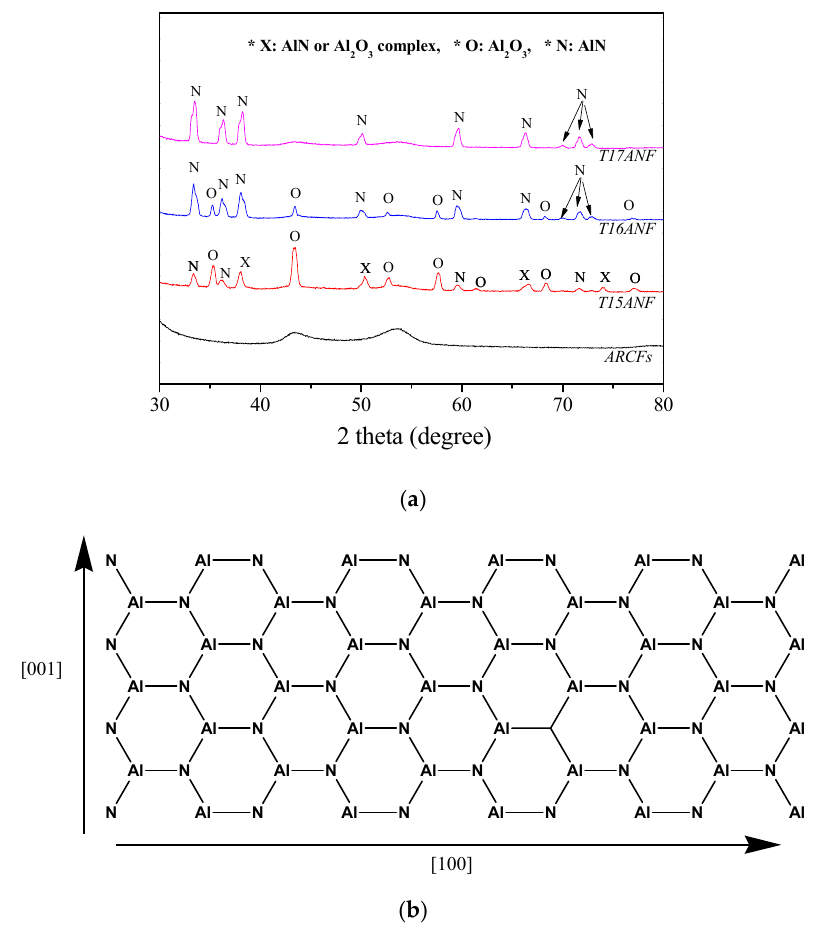
Figure 3. ( a ) XRD patterns of the products obtained from AlCuF as a function of reaction temperature for 1 h; ( b ) the schematic representation of the structural model of AlN formed at 1700 °C on the fiber.